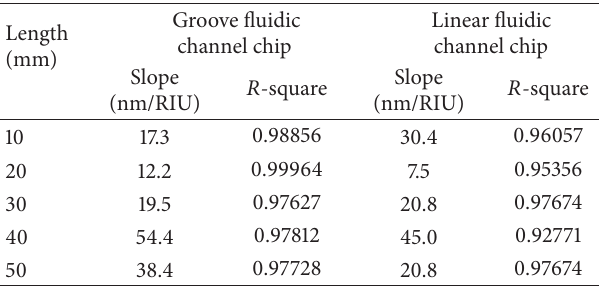
Table 4: Influence of the fluidic channel shape.